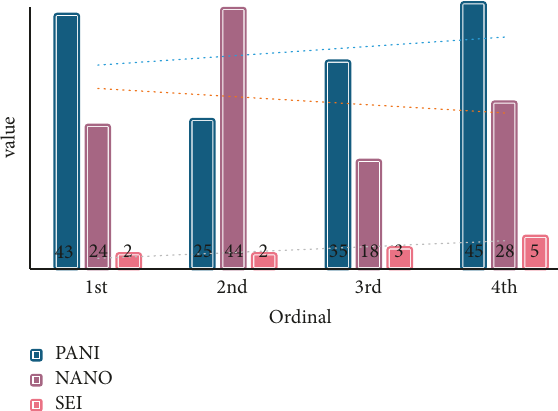
Figure 6: Cycling curves of nanocomposite fibers for the first 3 weeks.